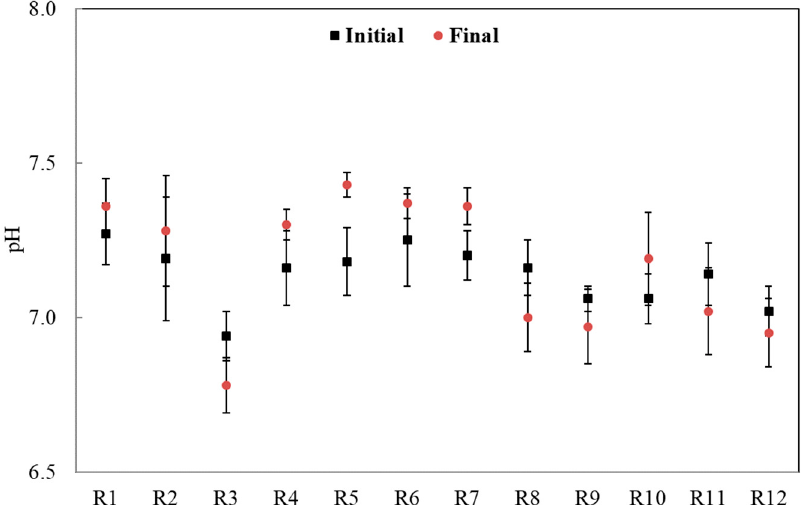
Figure 3. The pH value for reactors treating PFSF inoculated with three different inoculums and their mixtures.